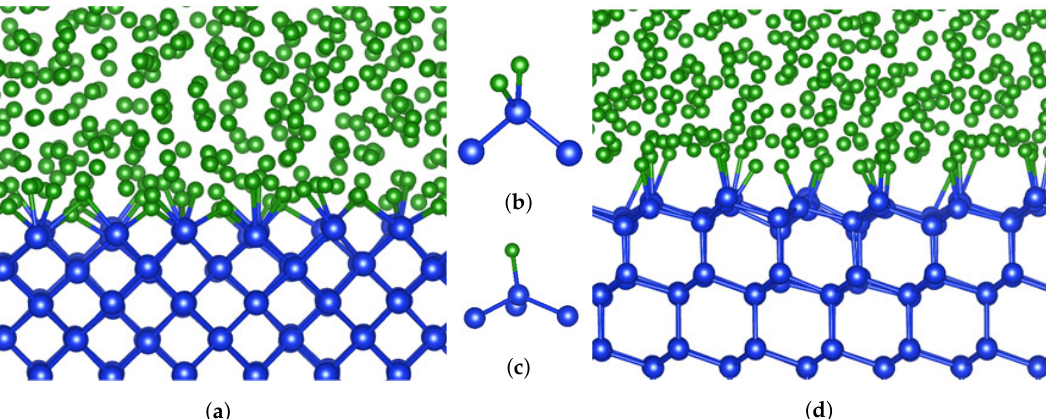
Figure 7. Snapshots of ( a , d ) the equilibrated interface and ( b , c ) related typical Si coordination for the Si{0 0 1}/a-B and the Si{1 1 1}/a-B interfaces, respectively. The green spheres represent B and blue Si.